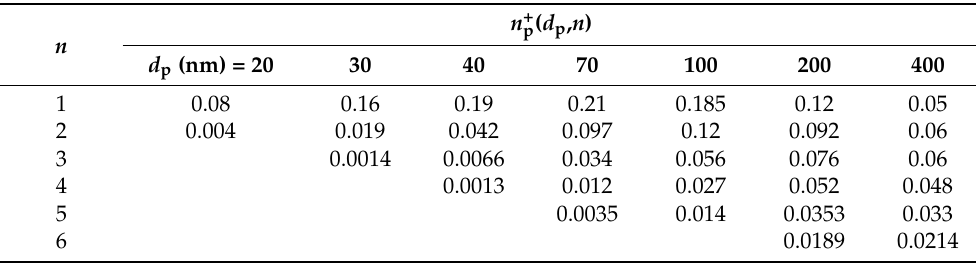
(cid:0) (cid:1) d p Table A1. Fraction n + p of n -times positive-charged particles of a nebulized NaCl aerosol (data of Simones et al. [33], Figure 4) for particle diameters d p (values for n = 5 und n = 6 were estimated by extrapolation of the charge